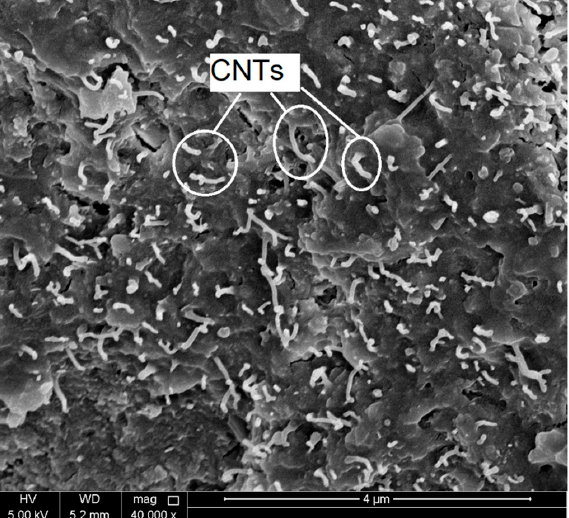
Figure 4. SEM image shows well-dispersed CNTs within the hydration products.